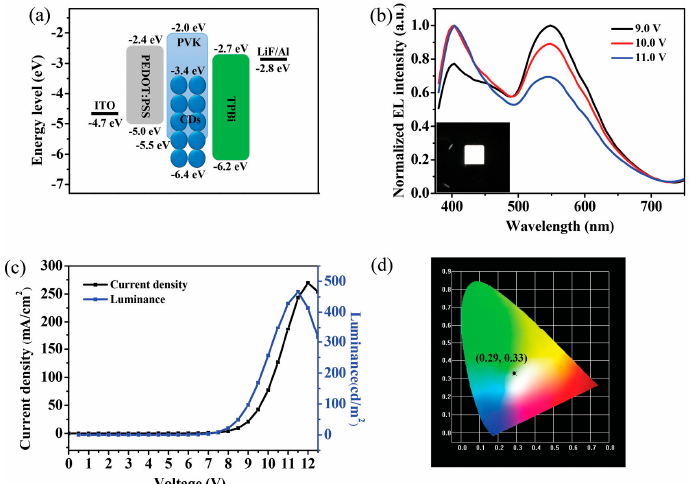
Figure 15. ( a ) The energy level diagram of the white CD-LED, ( b ) normalized EL spectra of the